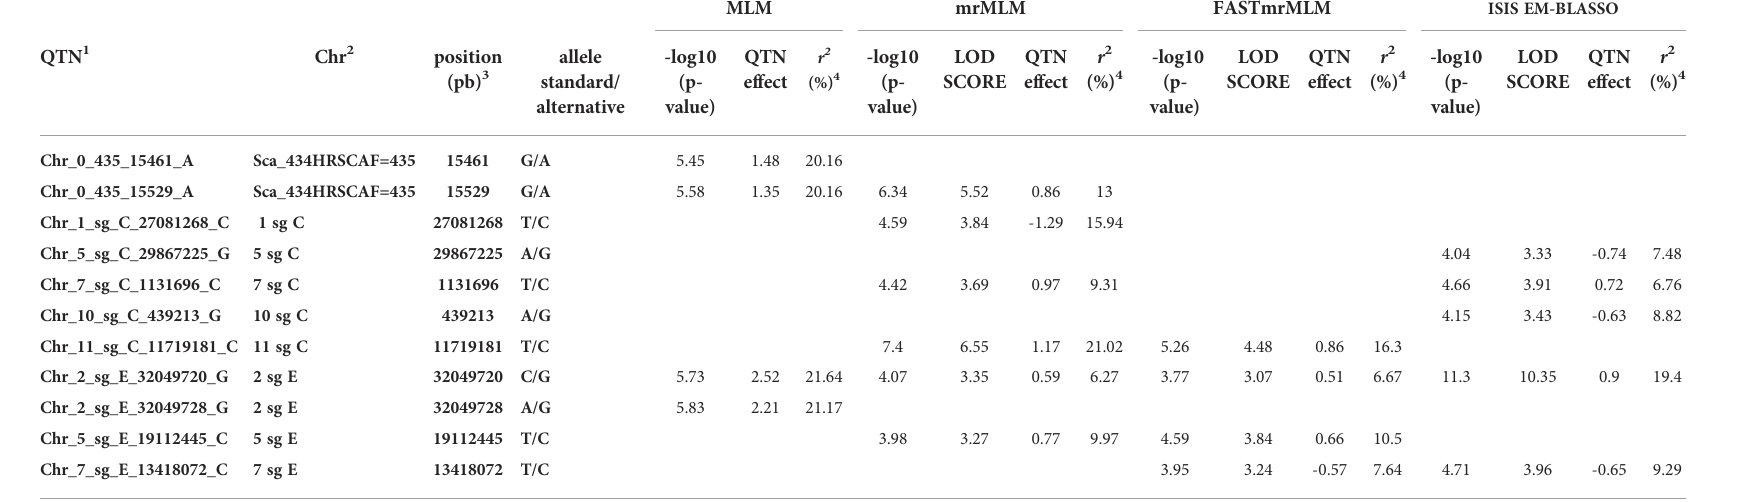
TABLE 1 Description of QTNs associated with resistance to BHB in C. arabica through the MLM, mrMLM, FASTmrMLM, and ISIS EM-BLASSO